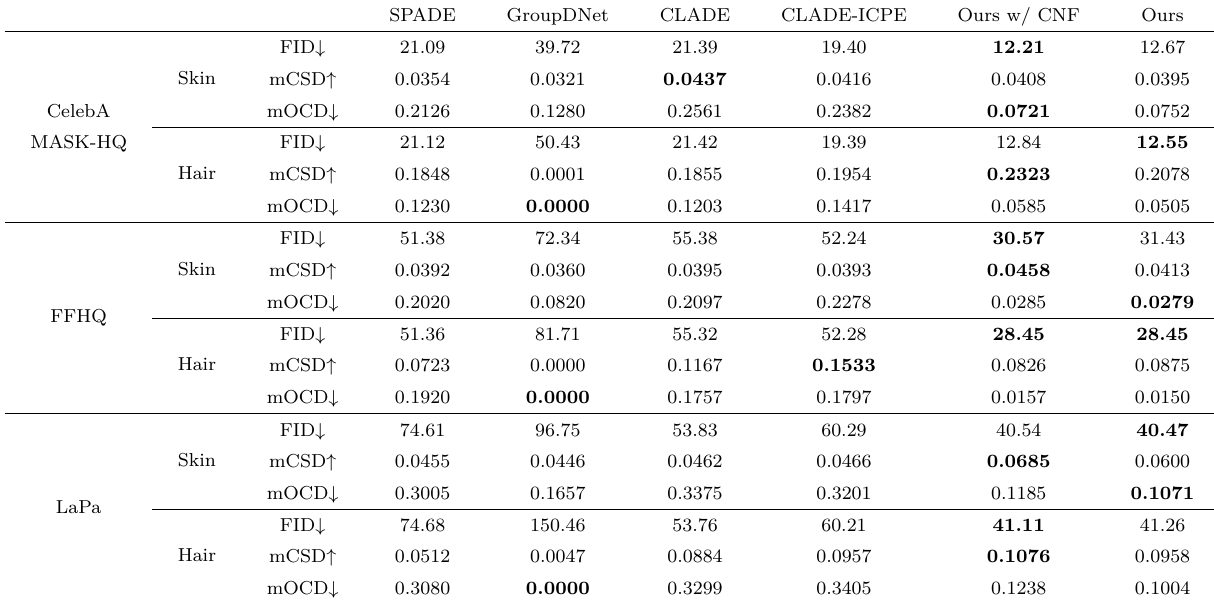
Table 4 Regional multi-modal synthesis